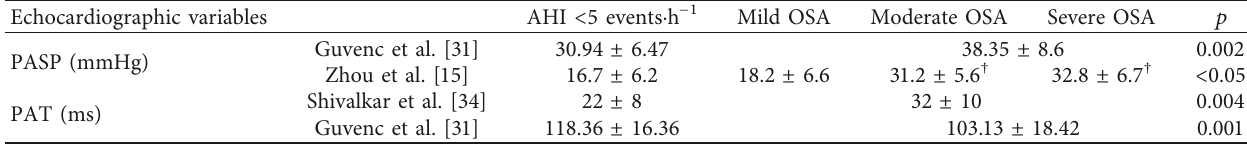
Table 8: Pulmonary hypertension parameters in relationship with OSA